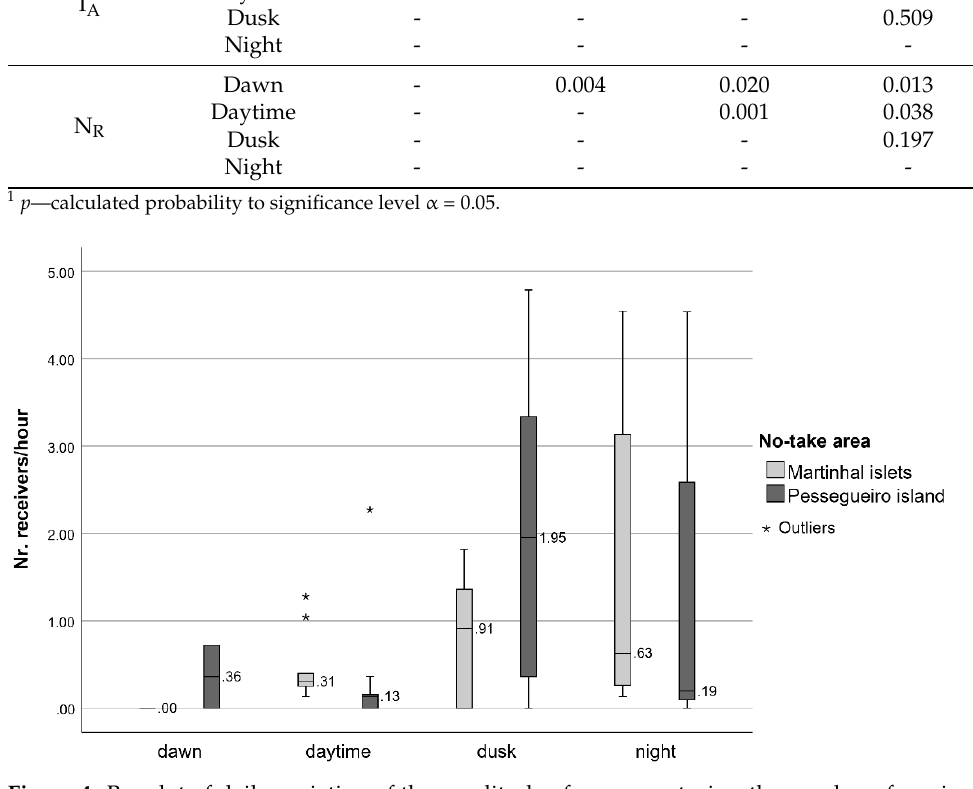
Figure 4. Boxplot of daily variation of the amplitude of movements, i.e., the number of receivers with detections per hour (N R ) calculated from individual fish released in the Pessegueiro island and Martinhal Islets no-take areas.